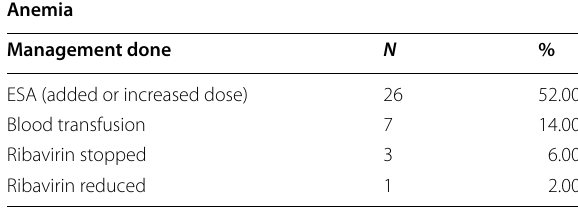
Table 6 Anemia (Hb < 10 g/dl)